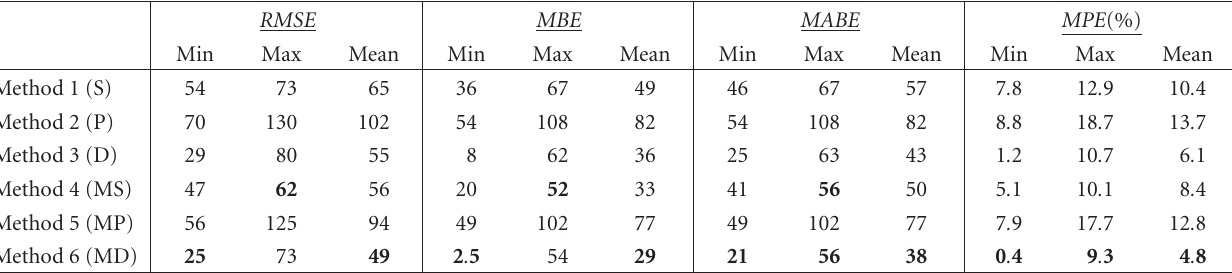
Table 2: Minimum, maximum, and mean values of errors for southern cities (Units are in Mj percent).